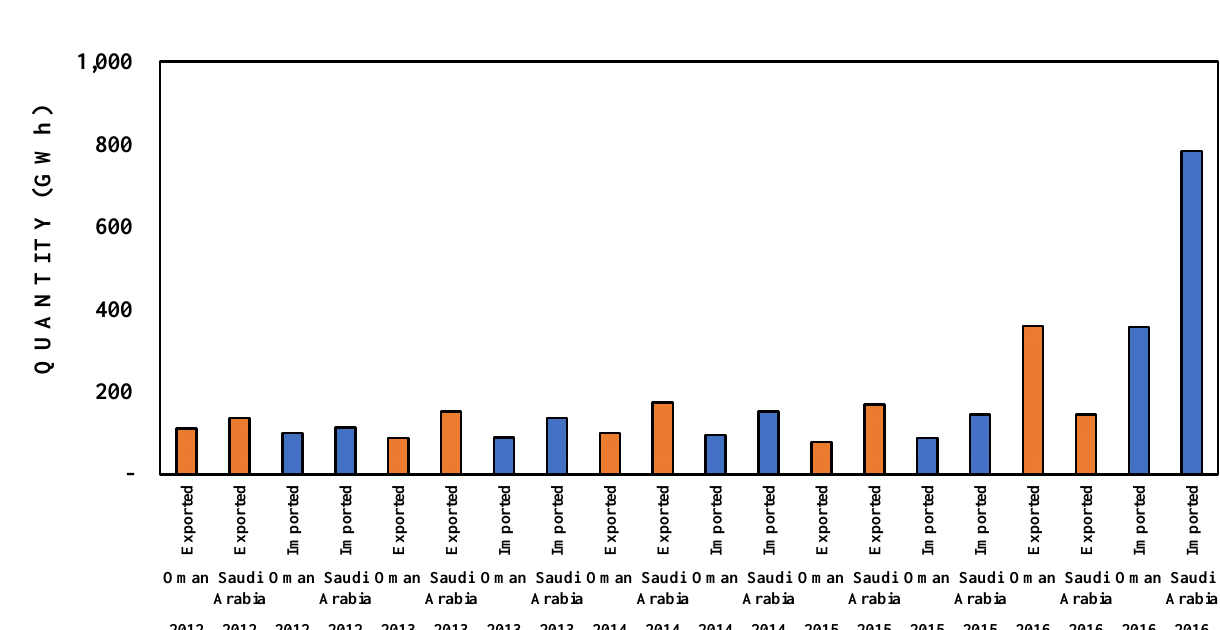
Figure 16. Export and import quantity (GWh) to Oman and Saudi Arabia [81].